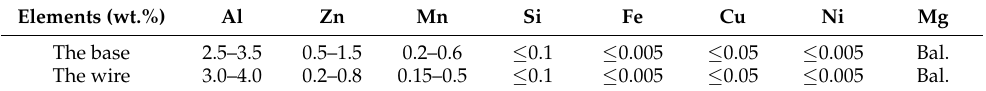
Table 1. Chemical composition of the AZ31 magnesium alloy base and wire. Elements